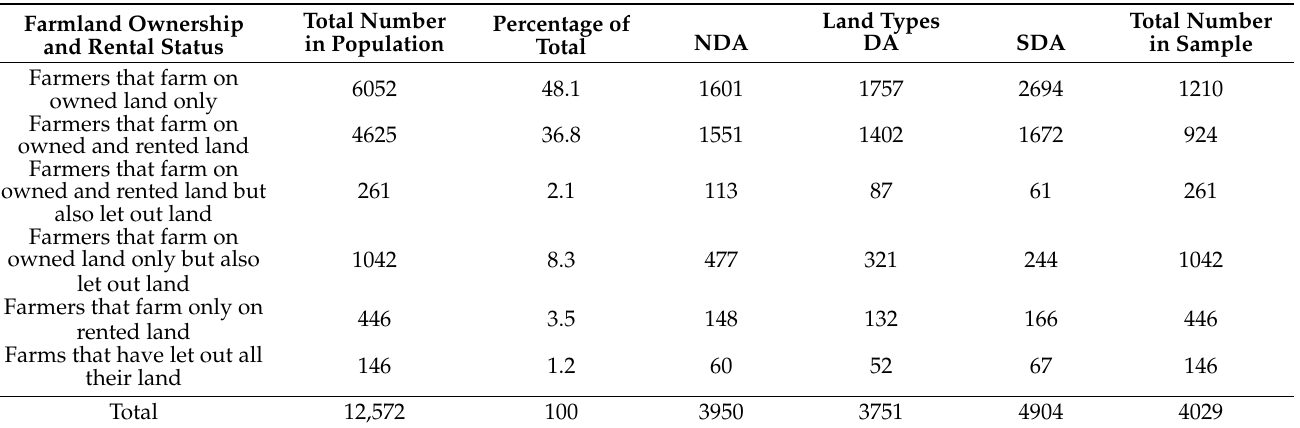
Table 1. Sample distribution across